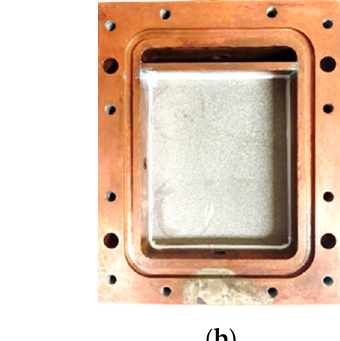
Figure 5. Schematic design of the evaporator. 1: vapor collector; 2: compensation chamber; 3: polycarbonate lid; 4: O-ring; 5: charging pipe; 6: copper evaporator body; 7: wick; 8: vapor grooves; 9: copperplate; 10: vapor pipe.